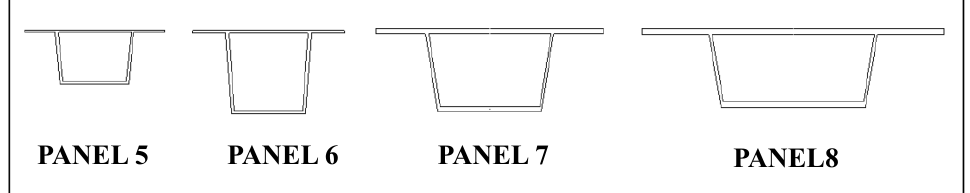
Figure 22. Geometry of optimized Shear Panels 5 to 8.